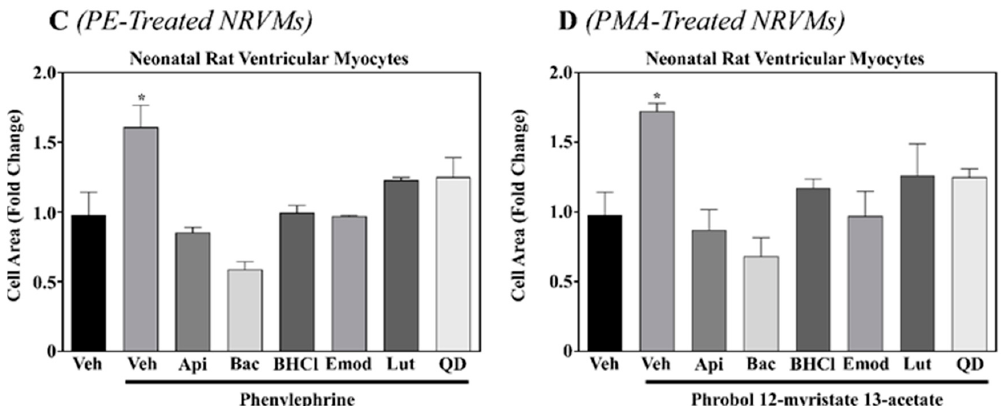
Figure 1. Select phytochemicals attenuate cardiac hypertrophy in response to PE or PMA. NRVMs were stimulated to hypertrophy with ( A ) phenylephrine (PE; 10 µM) or ( B ) phorbol 12-myristate 13-acetate (PMA; 50 nM) in the absence or presence of vehicle control or phytochemicals (Apigenin (Api), Baicalein (Bac), berberine hydrochloride (BHCL), Emodin (Emod), Luteolin (Lut), or Quercetin dehydrate (QD); All compounds were used at 10 µM). NRVMs were co-treated as indicated above and cells were fixed 48 h post-treatment and stained for α -actinin, atrial natriuretic peptide (ANP), and Hoescht. NRVMs were visualized with the EVOS FL microscope and ( C ) PE and ( D ) PMA treated cells quantified using Image J software and graphed with GraphPad Prism software. One-way ANOVA with Tukey’s post-hoc was performed and significance set at p < 0.05. *—Significantly different than all treatment groups.